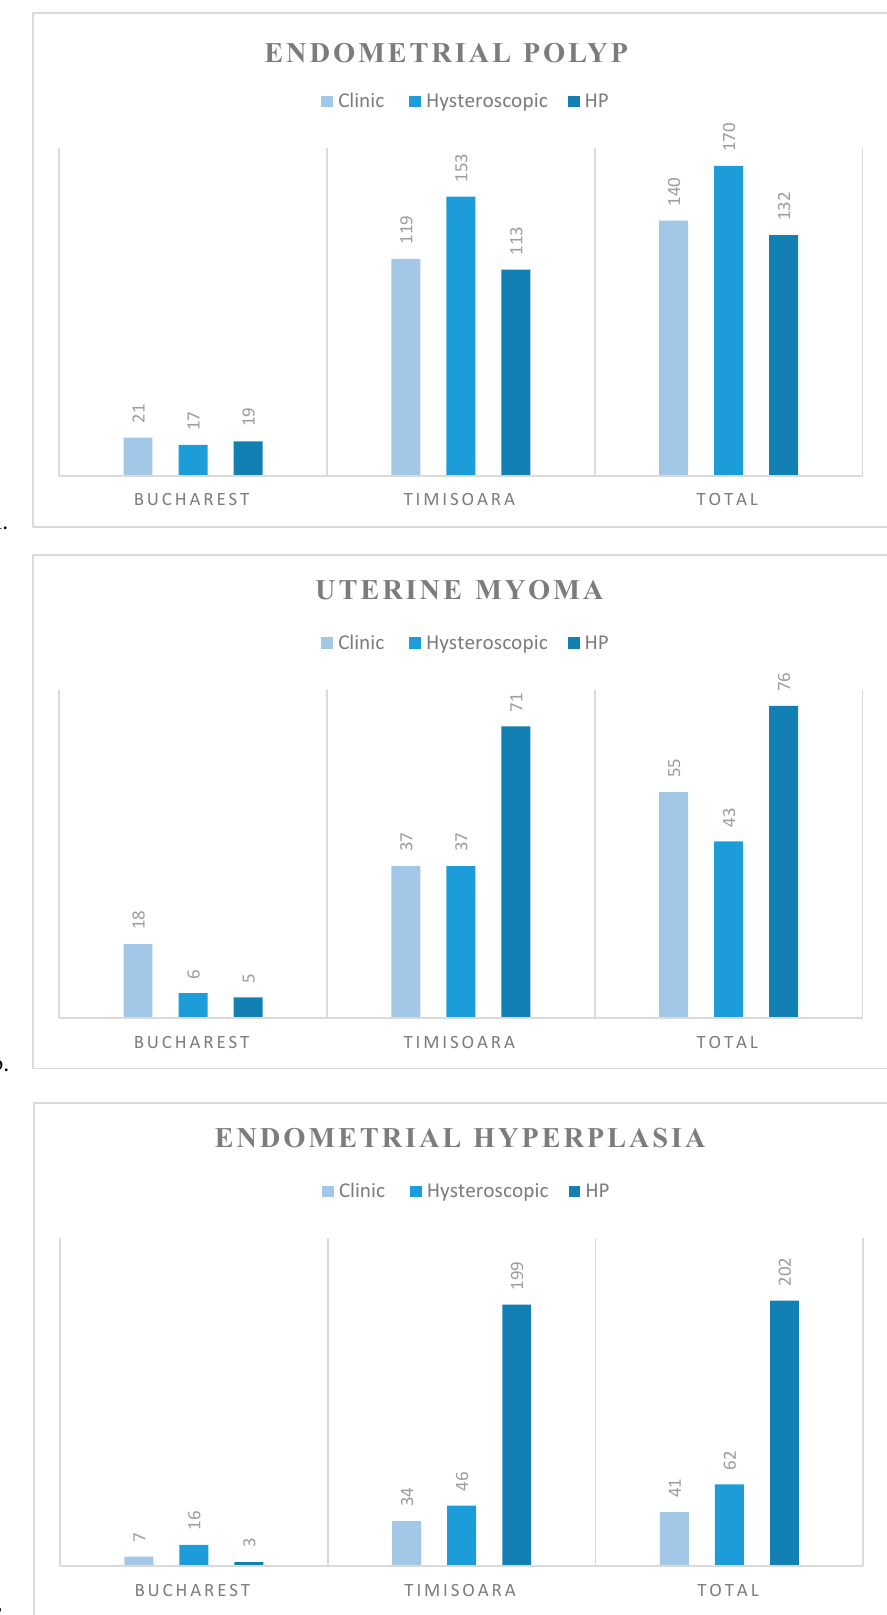
Figure 5. Comparison between clinical, hysteroscopic and histopathological diagnoses in each center and total evaluation for: ( a ) endometrial polyp; ( b ) uterine myoma; ( c ) endometrial hyperplasia. Data are presented as N .